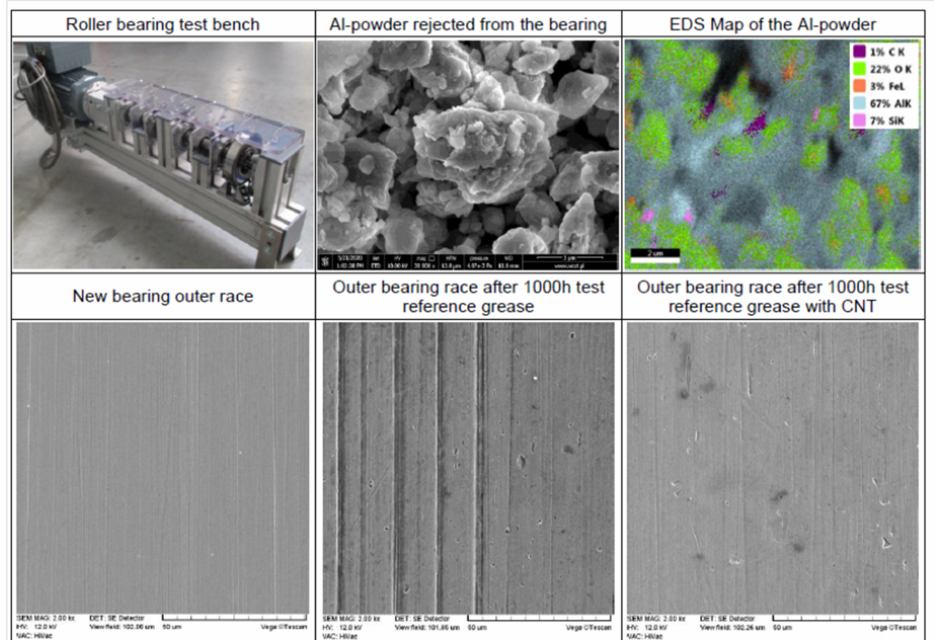
Figure 7. Bearing test bench and results obtained for roller bearings lubricated by reference lithium grease enriched with 0.1% of CNT A ( top row ); new ball bearing outer races and lubricated by reference lithium grease without CNT and with 0.5% CNT A after 1000 h of tests ( bottom row